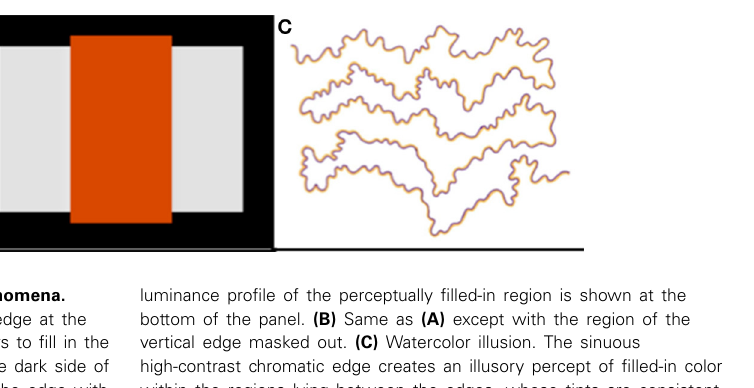
luminance profile of the perceptually filled-in region is shown at the bottom of the panel. (B) Same as (A) except with the region of the vertical edge masked out. (C) Watercolor illusion. The sinuous high-contrast chromatic edge creates an illusory percept of filled-in color within the regions lying between the edges, whose tints are consistent with the colors of the regional